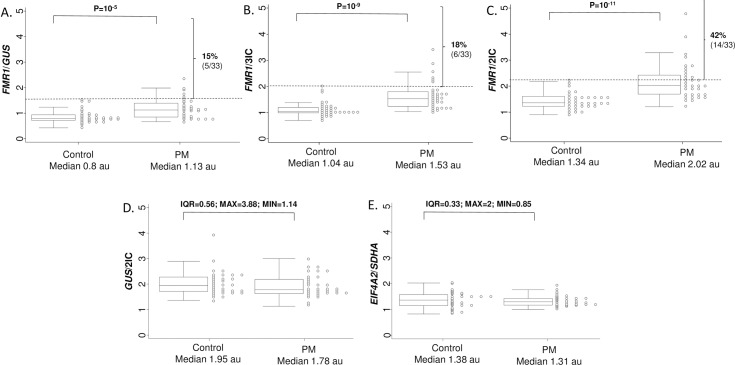
Inter-group mRNA level comparison plots between 33 PM and 33 control females.FMR1 mRNA was normalised to either (A)
GUS alone; (B) 3IC (GUS, EIF4A2 and SDHA); or (C) 2IC (EIF4A2 and SDHA, without GUS). (D)
GUS mRNA levels were normalised to 2IC (EIF4A2 and SDHA). (E) Variability in EIF4A2 to SDHA mRNA ratio (EIF4A2 and SDHA), between groups is also presented. Note: Broken horizontal lines indicate the maximum control value for each plot with percentages above this line indicating the proportion of PM females with abnormally increased FMR1 mRNA levels. Control and PM CGG groups reflect range in P values correspond to Table 1 (30). Interquartile range (IQR); maximum value (MAX); minimum value (MIN).